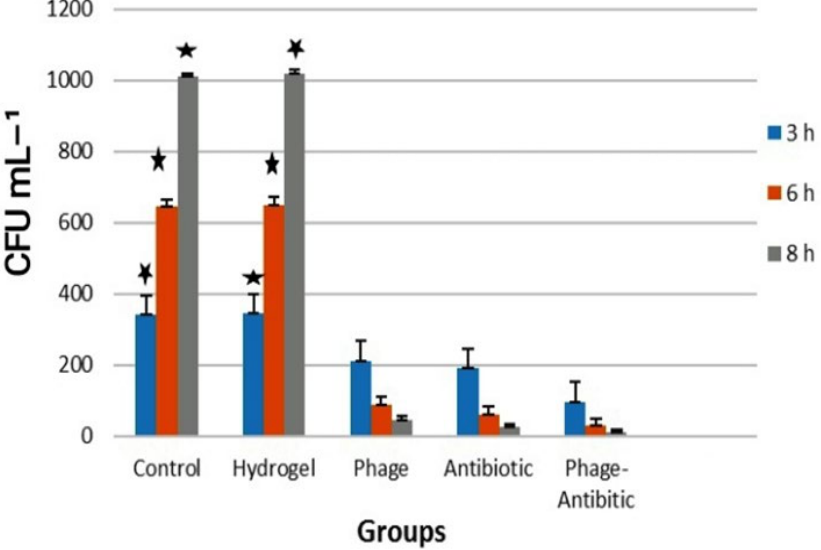
Figure 9. Inhibition zones of the hydrogels against P. aeruginosa .